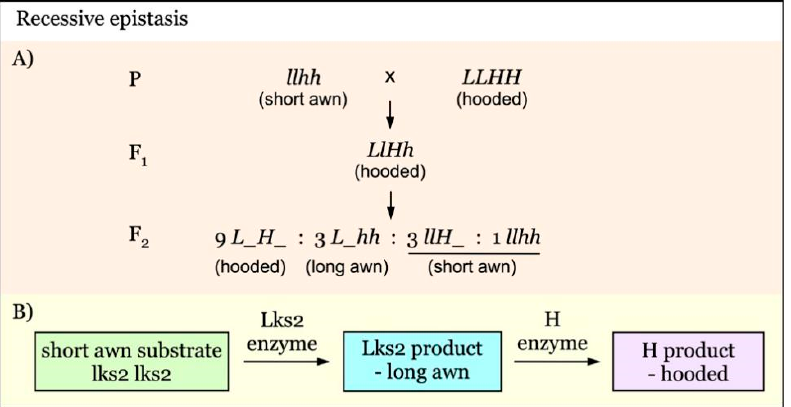
Figure 2. Model of interaction of awnness genes with recessive epistatic effect. ( A ). The short awn gene lks2 ( l ) is a recessive epistatic gene over the Hooded locus ( H / h ). The hooded awn phenotype is the result of coexistence of both L and H . At the lack of H gene ( hh ), Lks2 gives the long awn phenotype. ( B ). In the absence of Lks2 enzyme, there would not be LKS2 product and only short awns are produced regardless of the presence of H. Thus, the recessive lks2 acts as a recessive epistatic gene that suppresses the effect of the Hooded ( H or h ) gene.